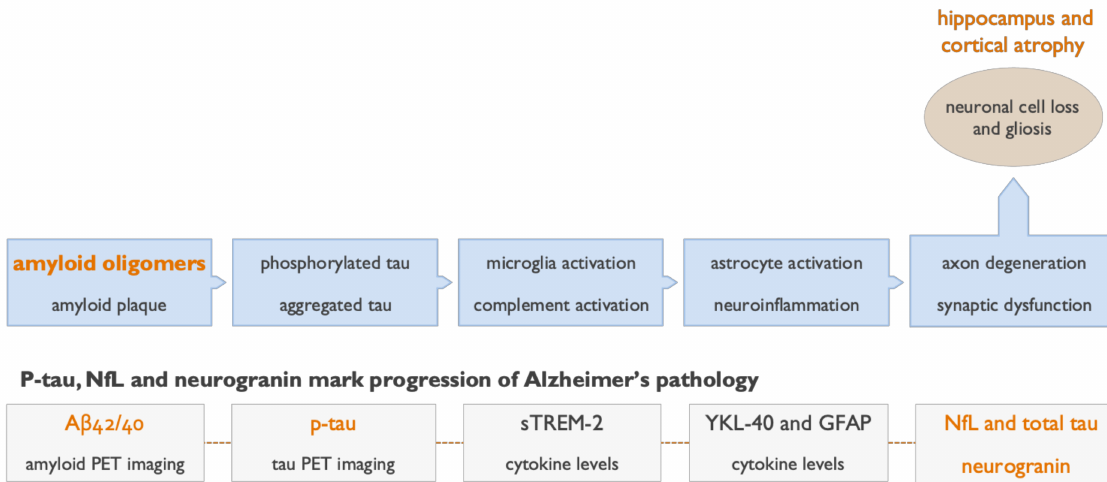
Figure 3. Fluid and imaging biomarkers detect and track progression of pathological processes in Alzheimer’s disease (AD). The core pathologies of AD can now be detected in patients using validated cerebrospinal fluid (CSF) assays for A β 42, A β 40, and several isoforms of p-tau. These CSF biomarkers of soluble amyloid and p-tau species indicate a pathological state, while the positron emission tomography (PET) scans show the actual accumulation of insoluble amyloid and tau over time. The toxic downstream effects of amyloid oligomers can be assessed using CSF and plasma biomarkers of neurodegeneration (neurofilament light chain protein (NfL) and total tau) and a biomarker of synaptic injury (neurogranin). Neuroinflammation can be assessed in CSF using the microglial marker (sTREM-2) and astrocytic marker (YKL-40), and in plasma using the astrocytic marker glial fibrillary acidic protein (GFAP) [43]. Insoluble fibrillar amyloid and aggregated tau in NFTs can be visualized and evaluated quantitatively by amyloid and tau PET imaging [8–10]. The use of volumetric magnetic resonance imaging (MRI) is well established in AD, accurately detects hippocampal and cortical atrophy reflecting neuronal cell loss and gliosis, and correlates with progression of